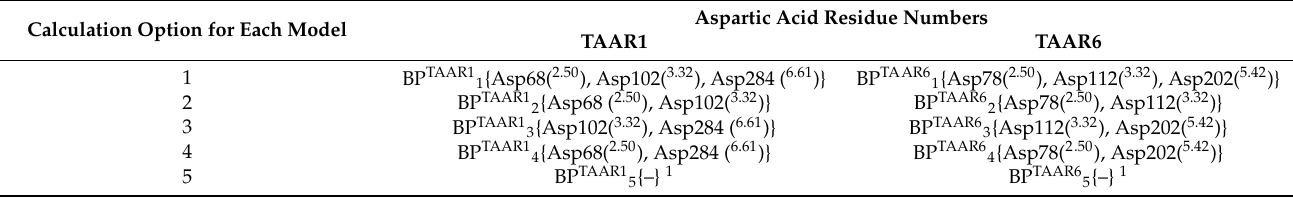
Table 8. Calculation options for the human TAAR1 and TAAR6 receptor models with Asp amino acid residues included in the binding